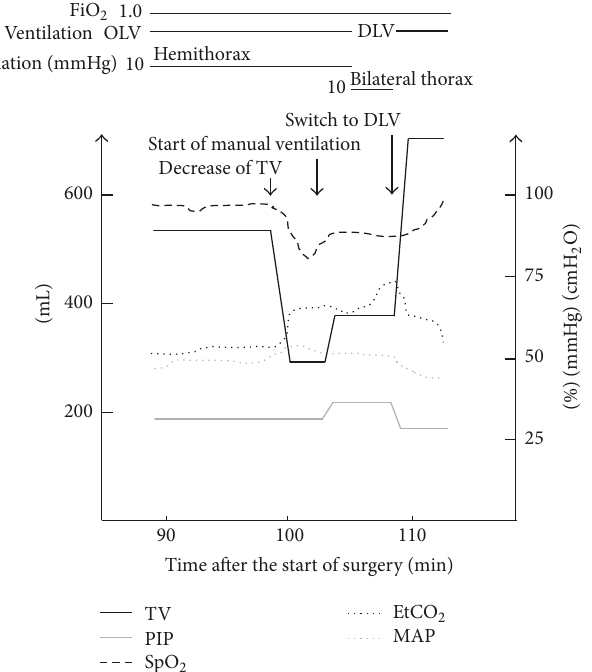
Figure 3: Changes of vital signs and ventilator settings in case 2. TV, tidal volume; PIP, peak inspiratory pressure; EtCO 2 , end-tidal carbon dioxide; MAP, mean arterial pressure; OLV, one-lung ventilation; DLV, double-lung